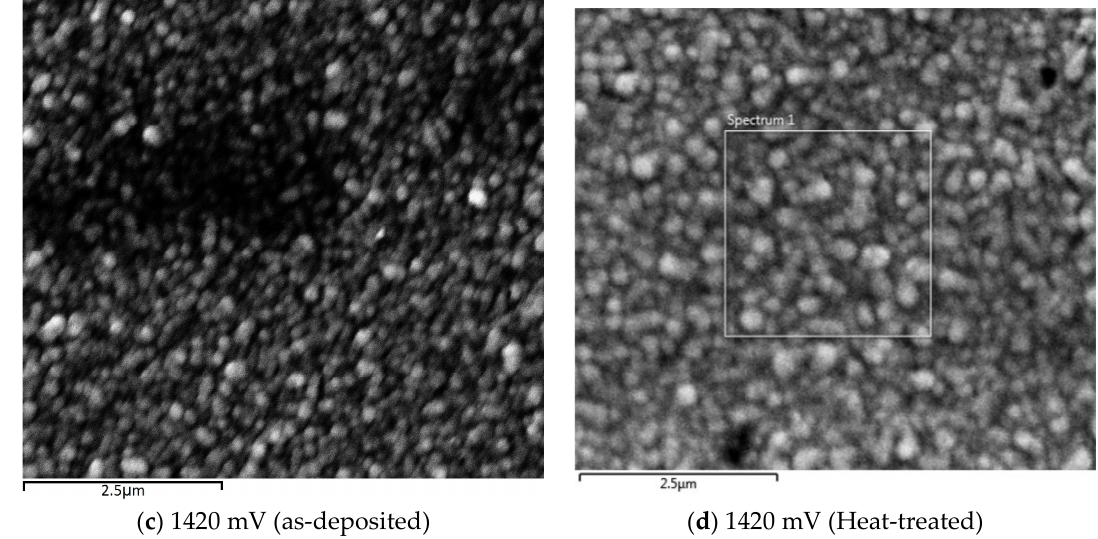
Figure 8. Typical SEM images of ( a–c ) as-deposited CdTe:Mg thin films grown at ( a ) 1360 mV, ( b ) 1460 mV, ( c ) 1420 mV, and ( d ) MgCl 2 -treated CdTe:Mg film grown at 1420 mV with high Mg presence in the bath.